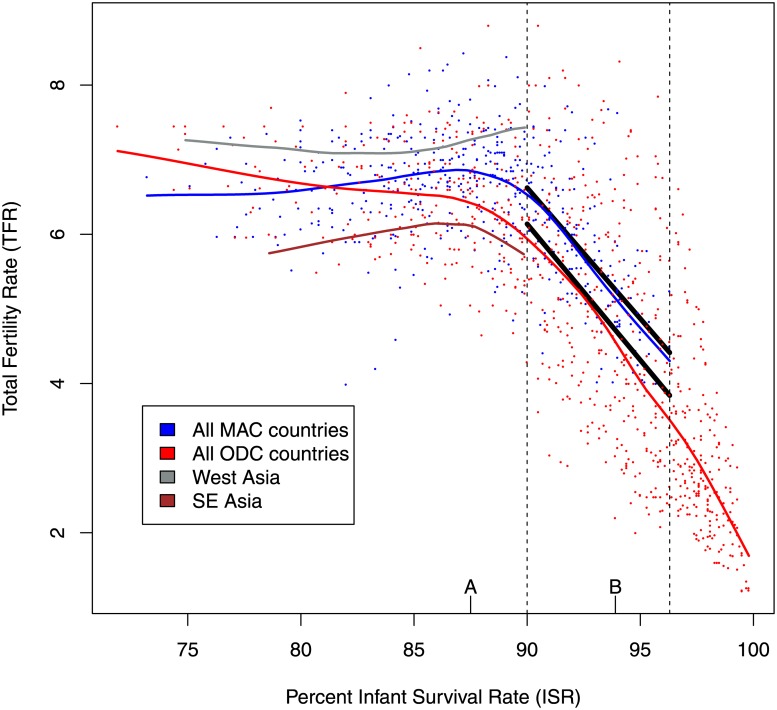
Each point is the TFR of a country during a 5-year period, plotted as a function of the country’s ISR in that period.Curves are local regression (LOESS) fits, using span = 1/3 [16]. Black regression lines are fitted in the approximately linear decline phase using all points with 90.0%≤ISR≤96.3%, indicated by vertical dotted lines. These have slopes -0.365 (ODC, 328 points, SE = 0.041) and -0.351 (MAC, 166 points, SE = 0.036), which are not statistically different. (In the linear model TFR = Mean + Region + ISR + Interaction, with independent, homoscedastic, Normal errors, the test for “no Interaction” gives t = 0.21, p = 0.84. When ODC and MAC error variances are not assumed equal, the slope estimates can be compared by a Welch t-test, which gives t = 0.26 and p = 0.79 on 380 degrees of freedom.) The extreme UN regions in the flat region (ISR ≤ 90%) are indicated by the olive and brown LOESS fits to West Asia and S.E. Asia, respectively. MAC and ODC slopes for 71.5%≤ISR≤87.5% are nearly flat (MAC slope = 0.04; ODC slope = -0.036) but differ statistically (the test for “no Interaction” gives t = 3.63, p = 0.0003). Markers A at 87.5% and B at 93.9% indicate the lower and upper limits for the range of slope overlap used in the single-country slope analyses (see S3 Text for further details).